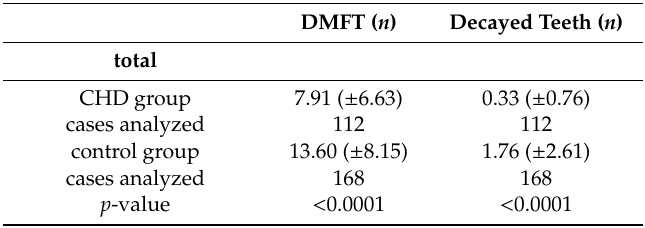
Table 3. Experience with caries among patients with CHD and healthy control subjects. Analysis of di ff erences between groups has been done with Mann–Whitney test, analysis between subgroups (CHD complexity) with Kruskal–Wallis